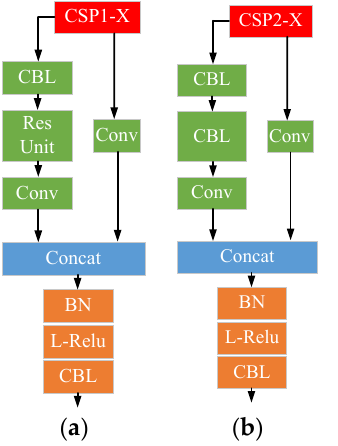
Figure 4. The architecture of CSPNets in YOLOV5: ( a ) CSP1-X; ( b ) CSP2-X.